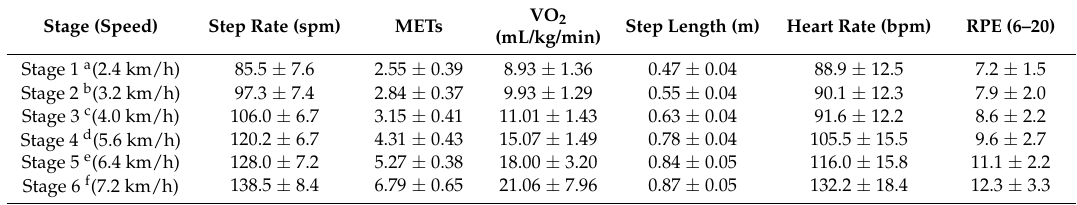
Table 1. Description of measured variables at each treadmill speed.